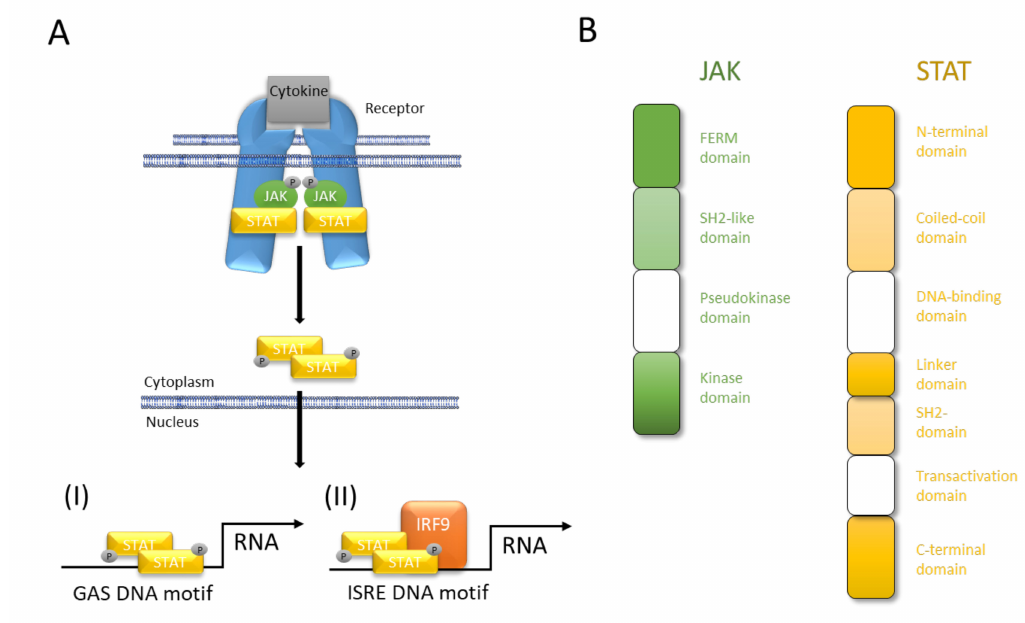
Figure 2. JAK / STAT pathway at a glance. ( A ) Cytokines interact with their corresponding receptor, which, after oligomerization, activates JAK and initiates JAK-mediated phosphorylation of its own cytoplasmic domain. Receptor phosphorylation causes STAT binding in close proximity to JAK that in turn mediates tyrosine-phosphorylation (p-Tyr) of the latter. STAT phosphorylation results in dimerization, nuclear translocation, DNA binding, and modulation of gene transcription. ( I ) All STAT can bind to interferon- γ (IFN- γ )-activated sequence (GAS) DNA motifs while ( II ) only STAT2 after forming a trimeric complex of STAT1–STAT2–IRF9 engages Interferon-stimulated Response Element (ISRE) DNA binding. ( B ) Four domains of JAK facilitate interaction with upstream receptors and promotion of kinase function (FERM domain), interaction with upstream receptors (SH2-like domain), control of kinase activity (pseudokinase domain), and trans-activation and tyrosine-phosphorylation of receptors, JAKs and STATs (kinase domain). The seven domains of STAT facilitate protein-protein interactions (N-terminal domain), protein–protein interactions and nuclear-localization (coiled-coil domain), nuclear import, DNA binding, and transcriptional activity (DNA-binding domain), structural organization and transcriptional activity (linker domain), dimerization and interaction with upstream receptors (SH2 domain), canonical signaling (transactivation domain), canonical and non-canonical functions (C-terminal